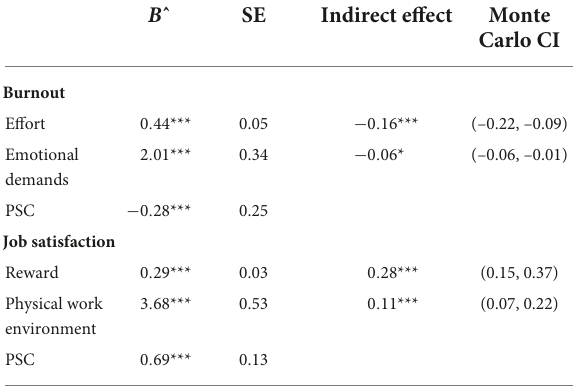
TABLE 5 Multilevel random coefficient models and Monte Carlo confidence intervals supporting H2 and